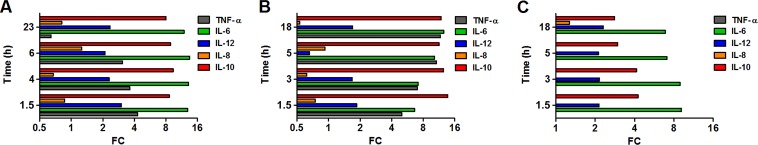
Schematic summary of the cytokines released by THP-1 (A), human PBMCs (B), and human MDMs (C) after stimulation with aCM. Incubation with aCM induced the release of a greater number of cytokines. In particular, IL-10, IL-6, and IL-12 were immediately produced, by both human monocytes (THP-1 cells and PBMCs) and human macrophages, and detected throughout the period of stimulation. Their increase was constant overall during the course of observations. aCM induced TNF-α production only by monocytes, although showing a different release pattern: its concentration increased in PBMCs during the time course (FC of 4.69 to 11.69), whereas in THP-1 cells it decreased (FC of 4.29 to 0.64). aCM-induced IL-8 production increased (FC of 1) at 5 to 6 h poststimulation (THP-1 and PBMCs) or at 18 h poststimulation (MDMs).